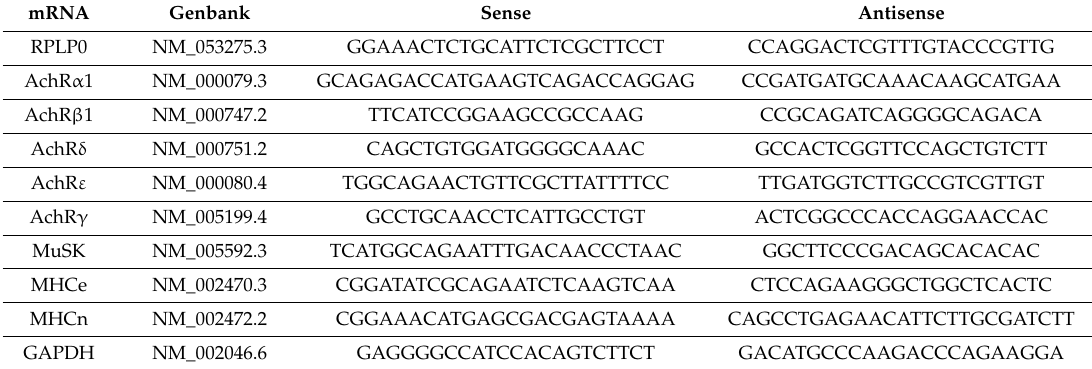
Primers used for PCR. RPLP0: Ribosomal Protein Lateral Stalk Subunit P0;